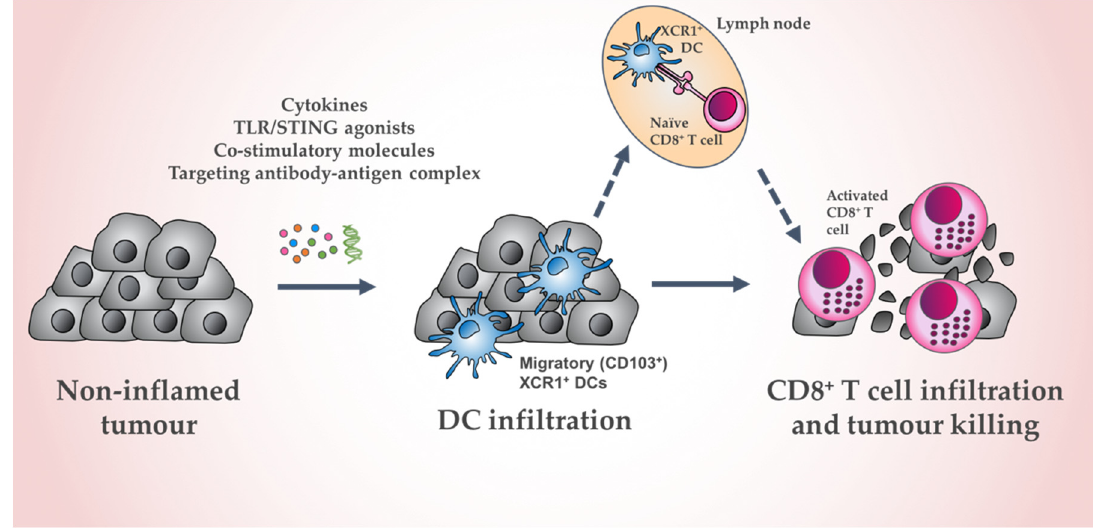
Figure 2. Schematic of in vivo XCR1 + DC activation to induce tumor cell death. Administration of cytokines, TLR/STING agonists, co-stimulatory molecules, and targeting antibody–antigen complexes can activate migratory (CD103 + ) XCR1 + DC in the tumor and lymphoid-resident XCR1 + DC. This can promote antigen acquisition, DC maturation, cross-presentation, and recruitment to the tumor site, culminating in increased CD8 + T cell-mediated tumor death.